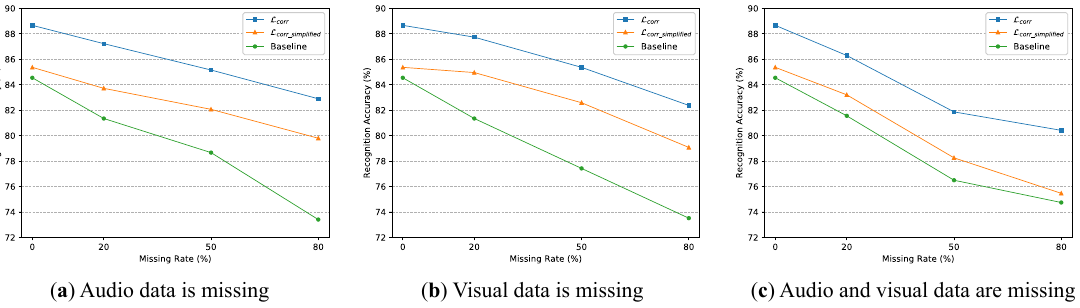
Figure 7. Three scenarios with missing modality during the testing process: only audio data are missing, only visual data are missing, and audio and visual data are missing. The performance of L corr method, L corr _ simple method and baseline method are compared. The missing rate of 0% means that there are no missing